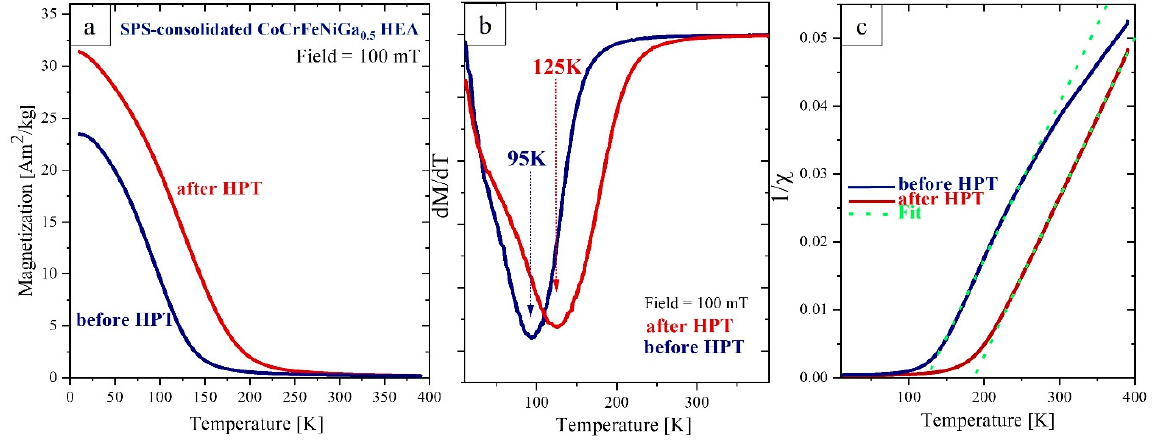
Figure 7. ( a ) Temperature dependent magnetization M(T) of SPS-consolidated CoCrFeNiGa 0.5 recorded at 100 mT before (blue) and after (red) HPT treatment. ( b ) The slope of M(T) yielding an estimate for the Curie temperature at its minimum. ( c ) Inverse susceptibility versus temperature. Dash lines are fits according to the Curie–Weiss law. Note the change in slope for the blue curve above 260 K (for details see text).